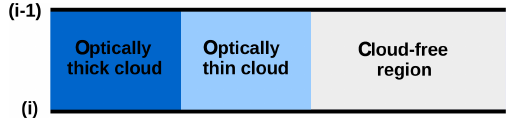
Figure 7. A model layer between levels (i − 1 ) and (i) divided into three